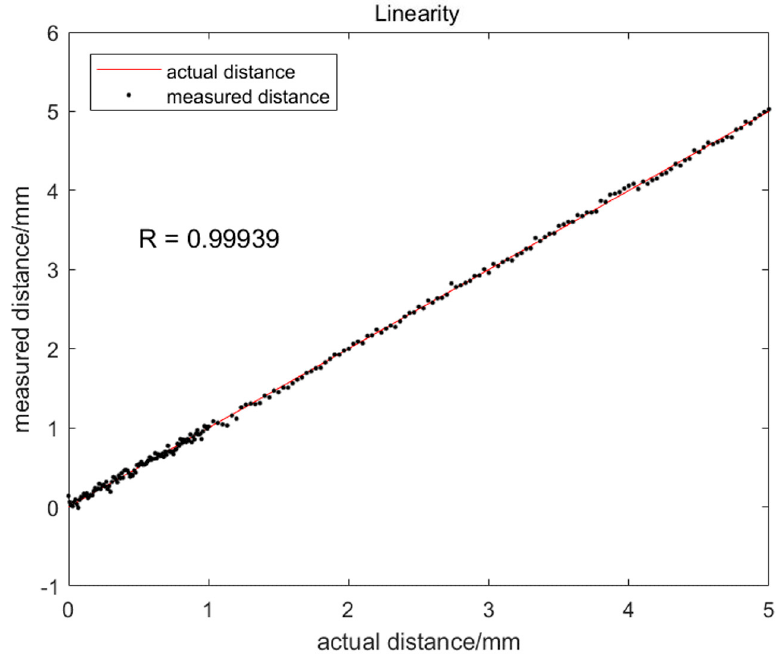
Figure 9. Linearity of Droplet Transfer Distance Detection Method. Figure 11. Linearity of Droplet Transfer Distance Detection